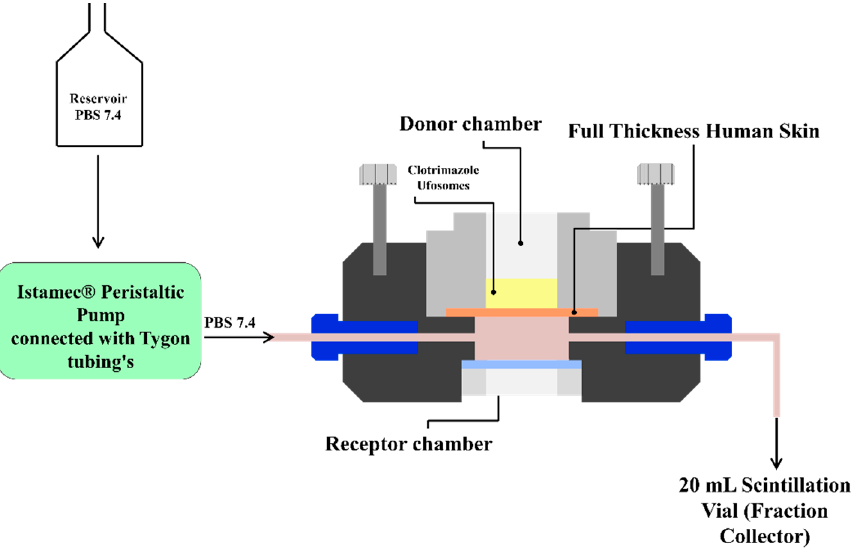
Figure 8. Automated flow through cells.